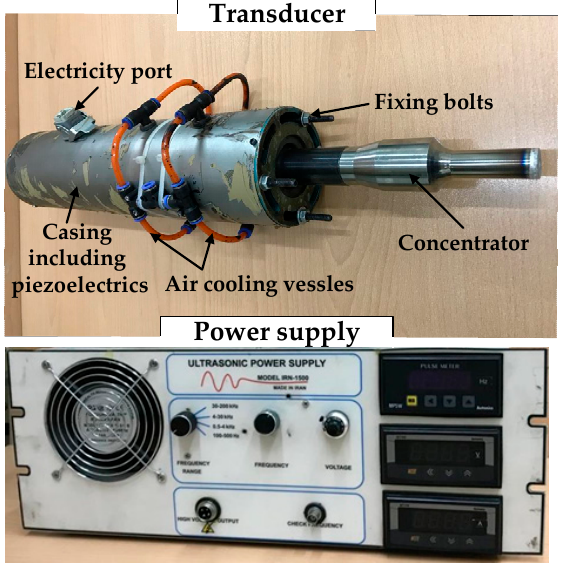
Figure 1. the fabricated ultrasonic piezoelectric transducer and power supply. Figure 1. The fabricated ultrasonic piezoelectric transducer and power supply.